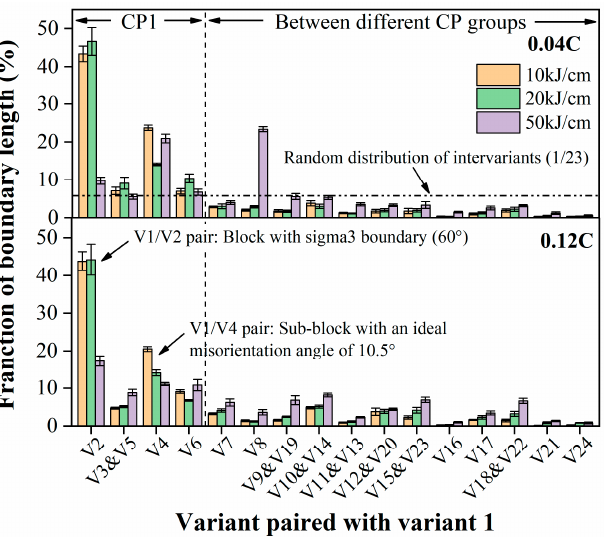
Figure 8. Average length fraction of intervariant boundaries between V1 and other variants in simulated samples with 0.04 wt.% C and 0.12 wt.% C under the different heat inputs.